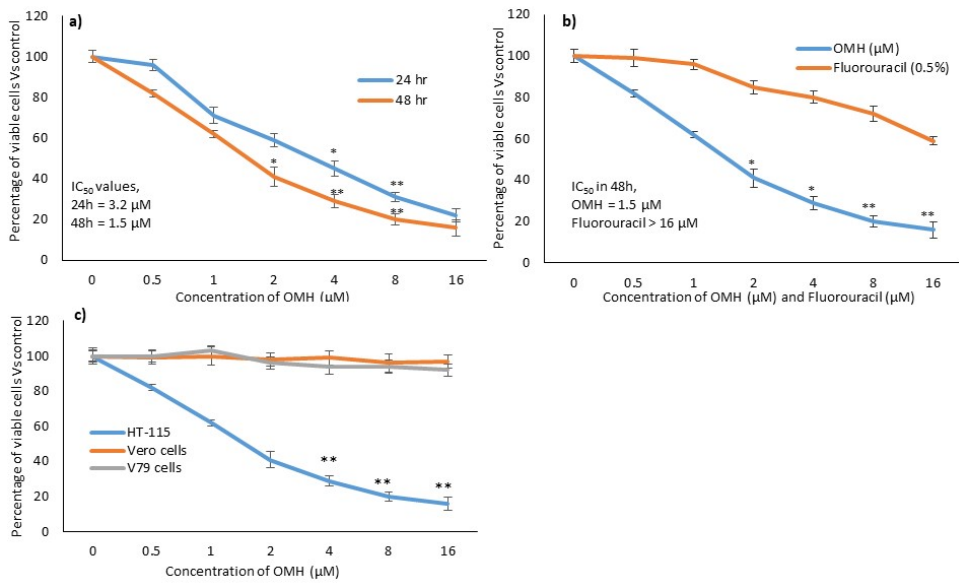
Figure 1. In vitro cytotoxic potential of ononitol monohydrate (OMH) on HT-115 cells after 24 h and 48 h ( a ). ( b ), showing the relative cytotoxic effect of OMH and fluorouracil in HT-115 cells after 48 h. ( c ), showing the comparative cytotoxic effect of OMH on HT-115, Vero, and V79 cells after 48 h. Data are expressed as the mean ± SD ( n = 6). * p ≤ 0.01 vs. Control, ** p ≤ 0.05 vs. control. For ( c ), ** p ≤ 0.05 vs. Vero and V79 cells.